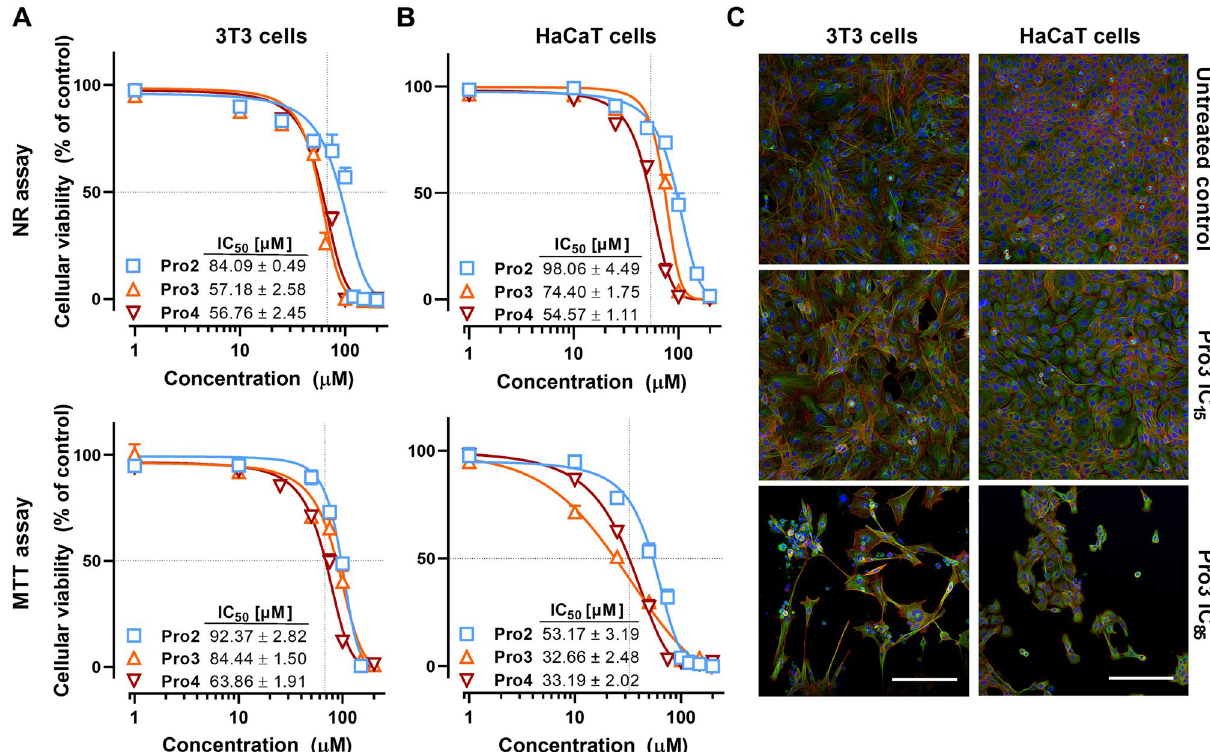
Figure 3. The viability of mouse fibroblast (3T3) and human keratinocyte (HaCaT) cell lines ( A, B , respectively) determined using NR and MTT assays after 48 h of incubation with the selected enhancers Pro2, Pro3, and Pro4. Data are presented as the means ± SEM; n ≥ 3. ( C ) Morphological changes of 3T3 and HaCaT cells treated with low (IC 15 ) and high (IC 85 ) doses of Pro3 (others shown in Supplementary Figure S1). Cells were stained for nuclei (blue), microfilaments (green), and microtubules (red). The bar represents 200